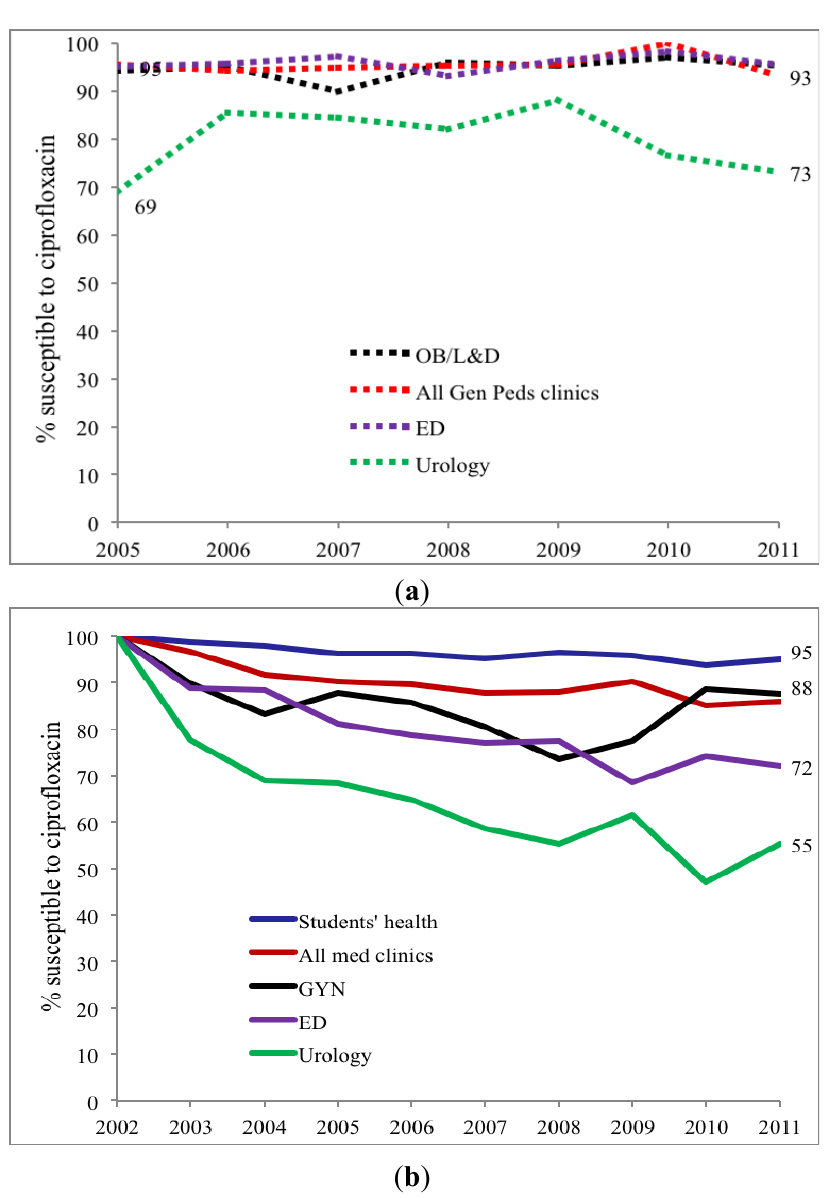
Figure 3. ( a ) Outpatient pediatric ciprofloxacin susceptibility trends for E. coli positive urinary cultures (ED = emergency department, All Gen Peds clinics = general pediatrics clinics, OB = Obstetrics clinics/Labor and delivery, URO = urology clinics); ( b ) Outpatient adult ciprofloxacin susceptibility trends for E. coli positive urinary cultures (Students’ health = undergraduate and graduate students’ clinic, ED = emergency department, All med clinics = general medicine clinics, GYN = gynecology clinics, URO = urology